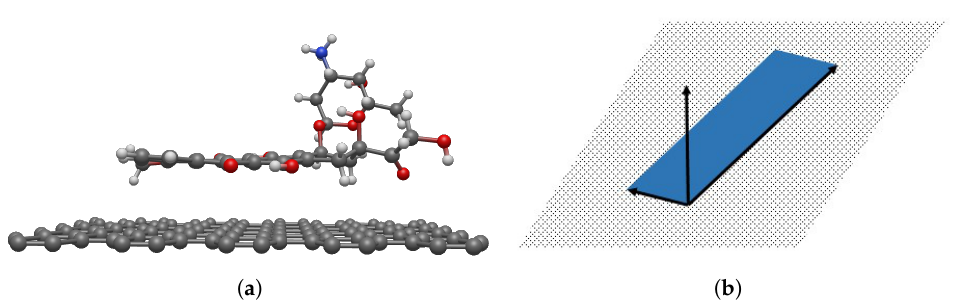
Figure 5. Stable configuration obtained from seed III-7 with ( a ) atomic structure and ( b ) vector representation for the interaction between DOXH and graphene.